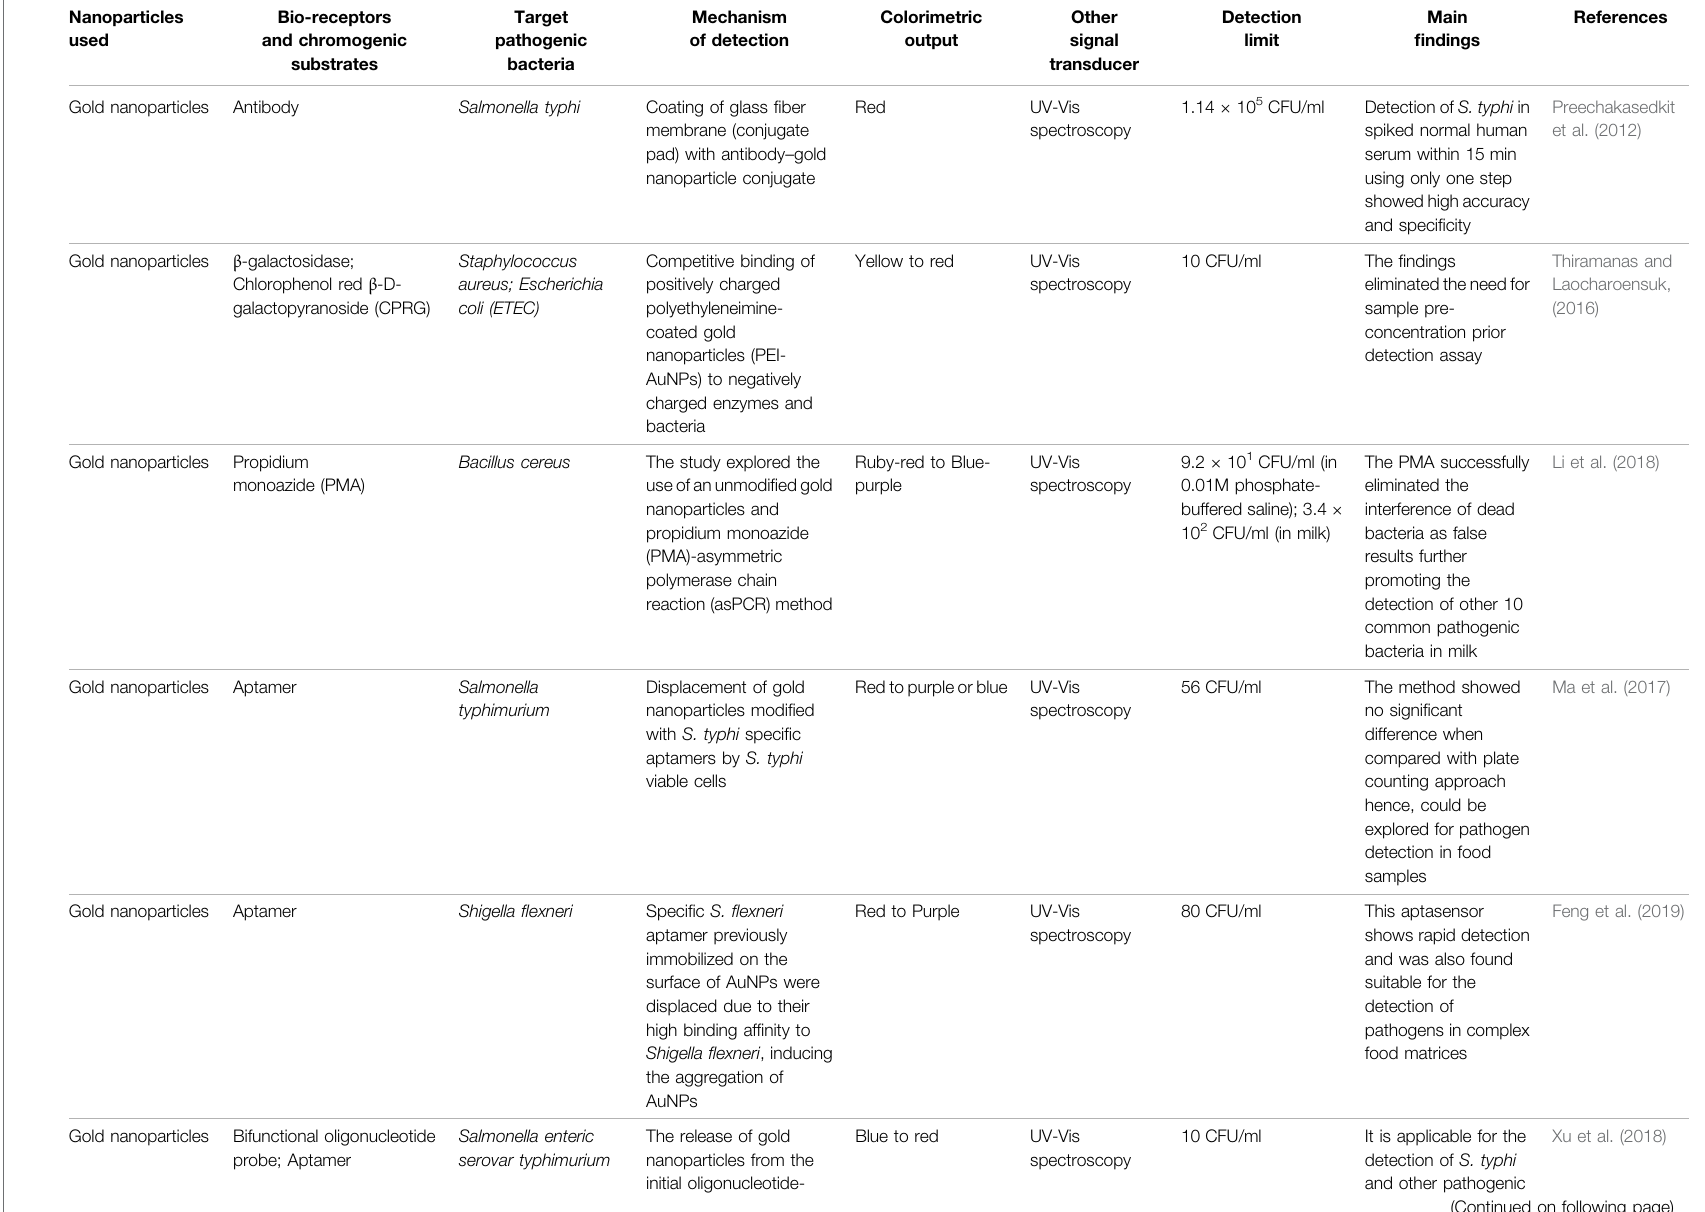
TABLE 2 | Summary of studies that have applied bio-receptors and chromogenic substrates for the detection of pathogenic bacteria. Nanoparticles